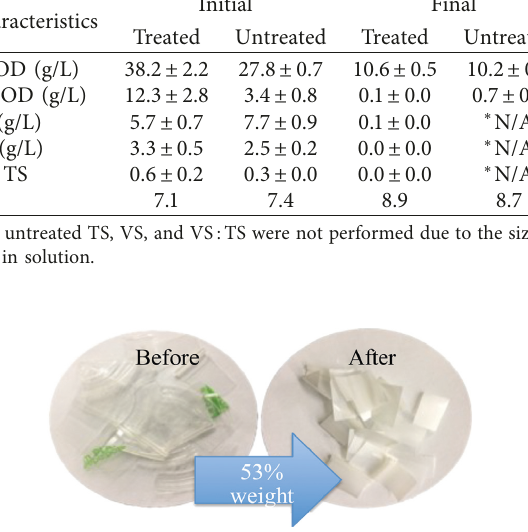
Figure 3: Comparison of untreated crystalline PLA before and after BMP